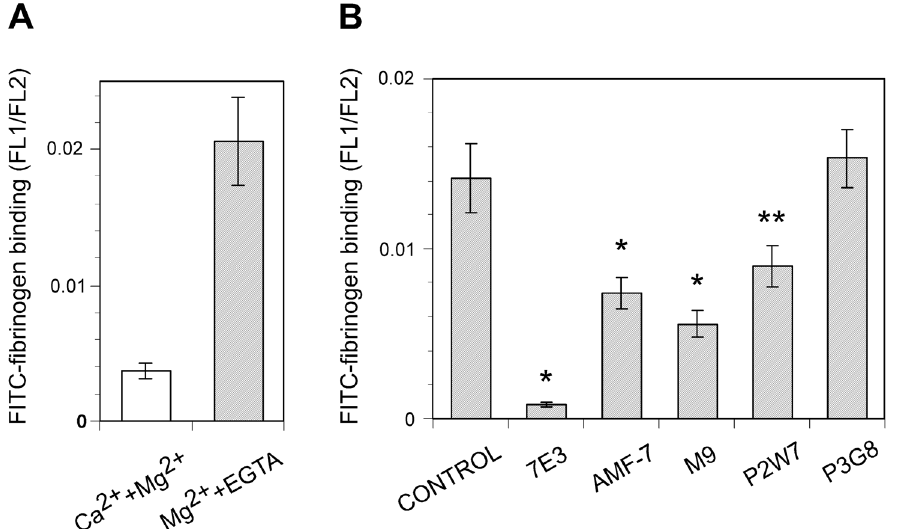
Figure 5. Effect of anti- a V b 3 mAbs on fibrinogen binding. A. FITC-fibrinogen binding to cells expressing a V b 3 in the presence of 1 mM Ca 2 + and 1 mM Mg 2 + (open column) or in the presence of 2 mM Mg 2 + and 5 m M EGTA (hatched column) is shown. The ratio of the MFI (FL1) to the MFI (FL2) in the gated cell population was used to normalize the binding with the expression of a V b 3 on the cell surface. B. FITC-fibrinogen binding to cells expressing wild-type a V b 3 in the presence of 2 mM Mg 2 + and 5 m M EGTA was examined. Binding in the presence of 100 m g/mL of the indicated mAb is shown in the hatched column. An equivalent volume of PBS, instead of the mAb solution, was included to obtain the control binding. The asterisks indicate statistically different binding abilities, compared with the control (* P , 0.01, ** P ,